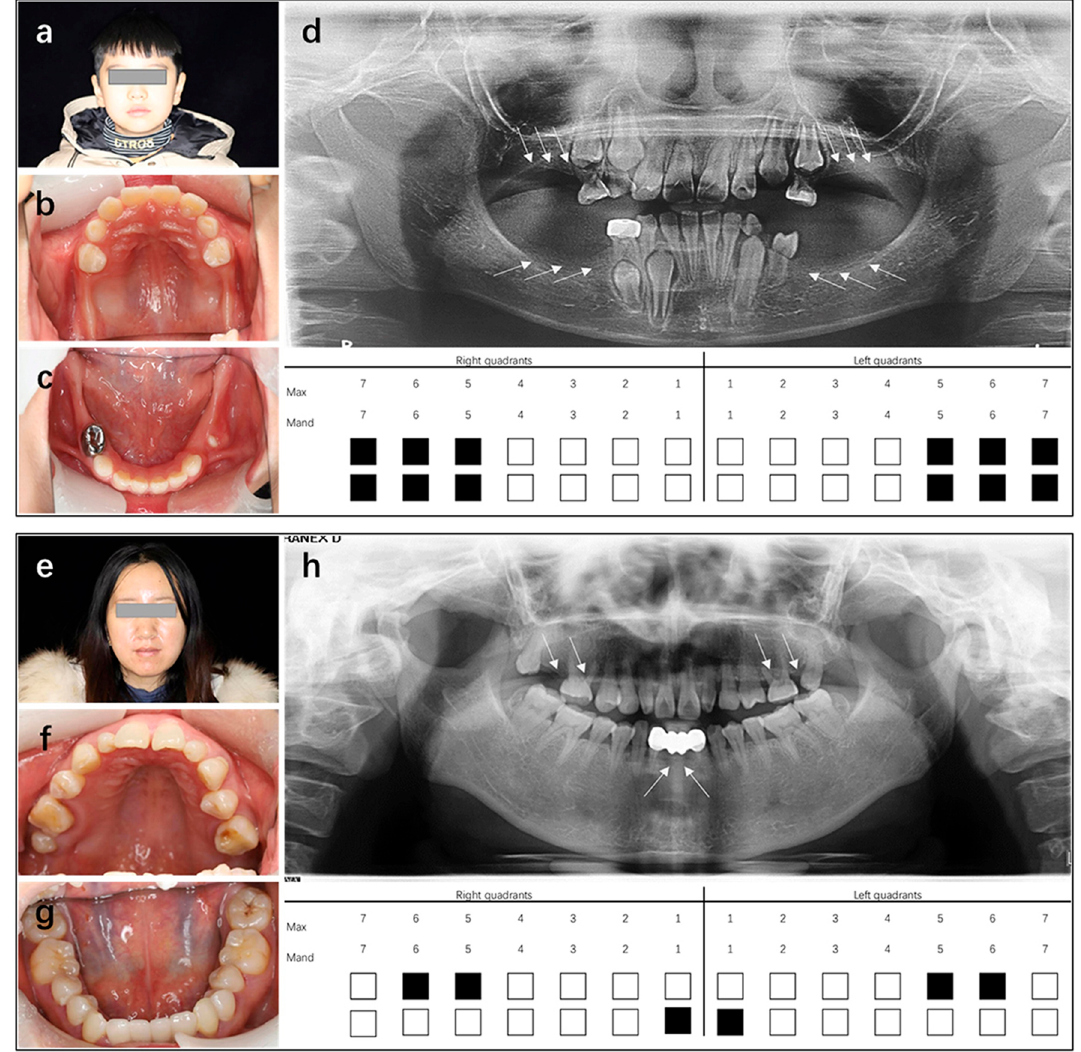
Figure 2- Dental characteristics of a Chinese family with non-syndromic oligodontia. a-d: (a) Facial characteristics of the proband; (b-c) Intraoral images; (d) Panoramic radiographs and schematic diagram of missing teeth; (e) Facial characteristics of the proband’s mother; (f-g) Intraoral images; (h) Panoramic radiographs and schematic of missing teeth. Black squares indicate missing teeth; Max, maxillary; Mand,